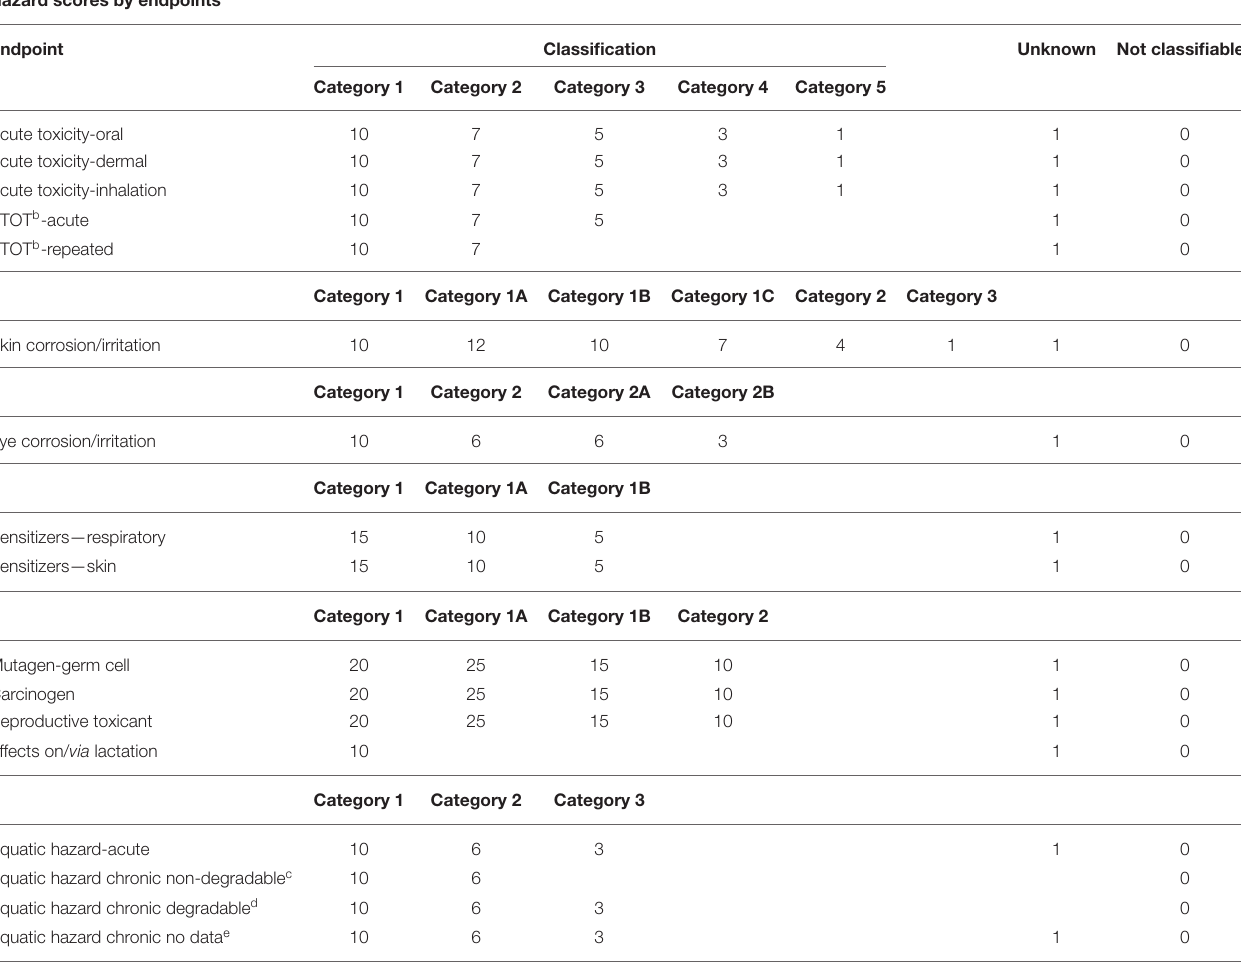
TABLE 1 | Hazard Scores for individual GHS endpoints and categories. Hazard scores by